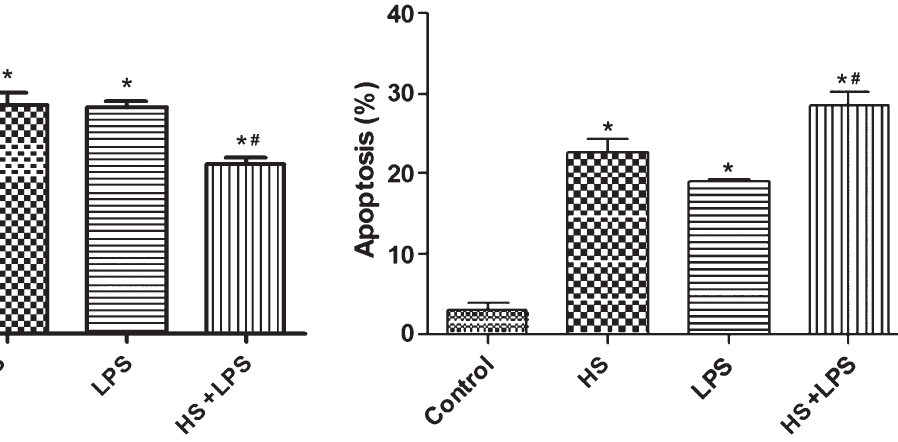
Figure 3. Effects of heat stress (HS) and lipopolysaccharide (LPS) on the apoptosis ratio of IEC-6 cells. Data are reported as means±SD, n=6. *P , 0.01 vs control, # P , 0.05 vs LPS or HS (one-way ANOVA